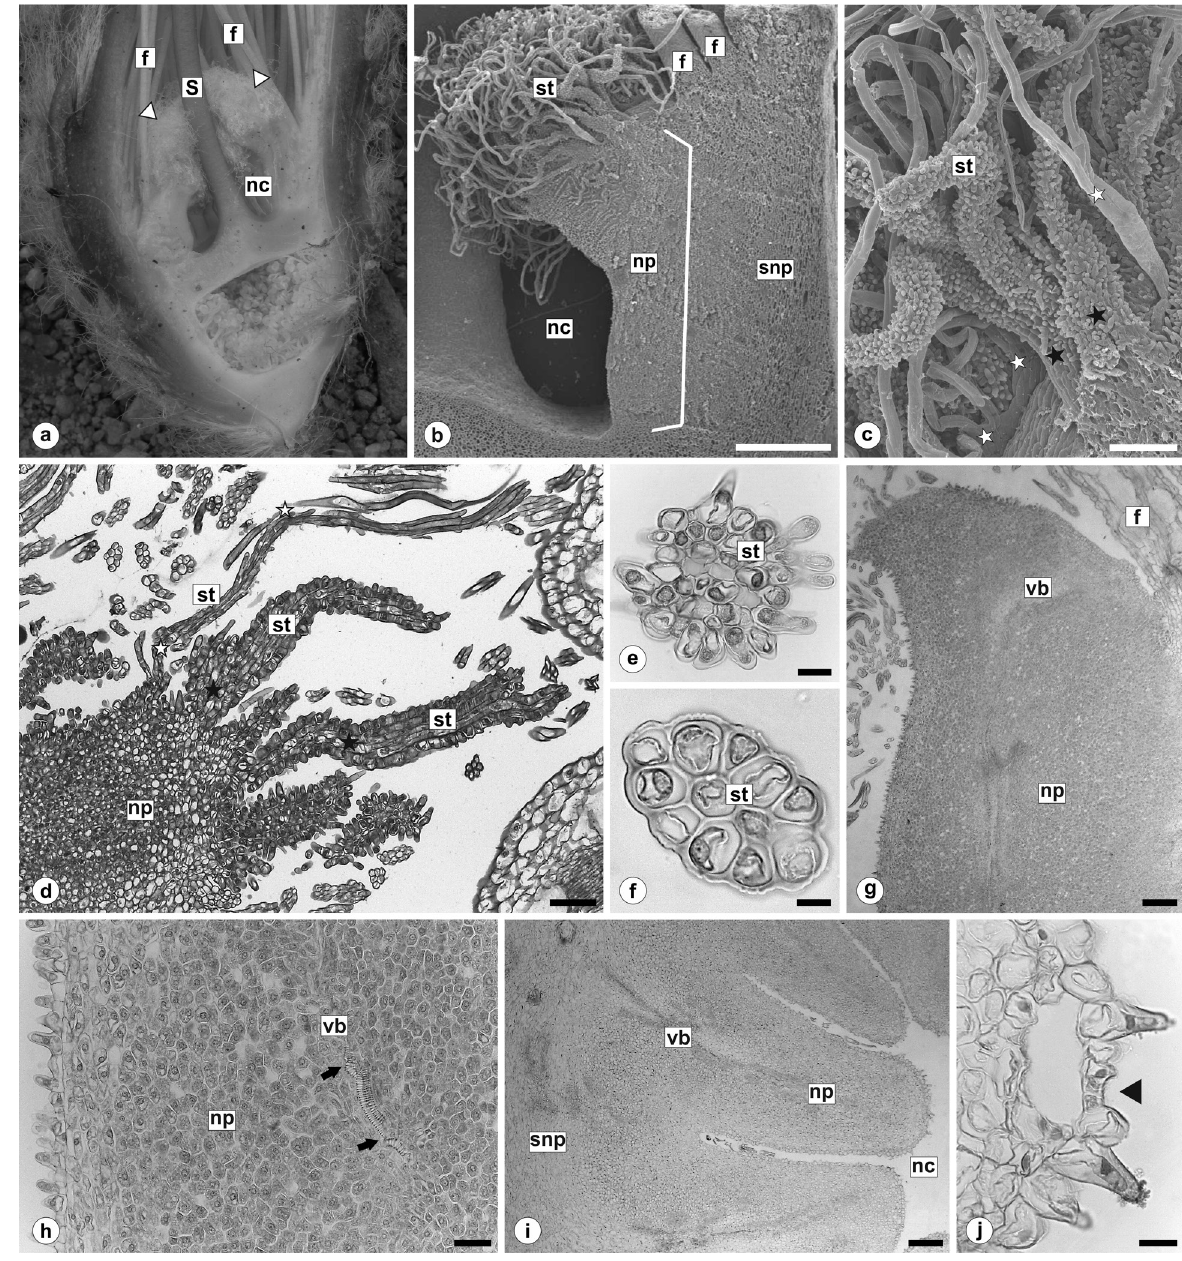
Figure 3. Floral nectary morph-anatomy of Denmoza rhodacantha. a-b Longitudinal sections. a Basal portion of flower, note the nectar chamber surrounding the base of the style, with a “plug” of curled trichomes (white arrowheads). b SEM of portion of nectar chamber. c Detail of staminodes born in the upper portion of the nectar chamber, note differences in the bases of the curled trichomes (black starts and white starts). d Light micrographs of non-vascularized staminodes, note the morphological differences in the bases (black starts and white start). e and f transversal section of staminodes. g Longitudinal section of floral nectary wall. h Detail of nectary wall showing traces of xylem and phloem penetrating and branching deeply into the nectariferous parenchyma (arrows). i Cross section of nectar chamber, observe the pattern of peaks and valleys of the wall. j Detail of nectarostoma (arrowhead), with conspicuous sub-stomatic chamber. Abbreviations: filaments (f), nectar chamber (nc), nectariferous parenchyma (np), sub-nectariferous parenchyma (snp), style (S), vascular bundles (vb). Scales: b 500 µm; c, e, g 200 µm; f 20 µm; d, h 50